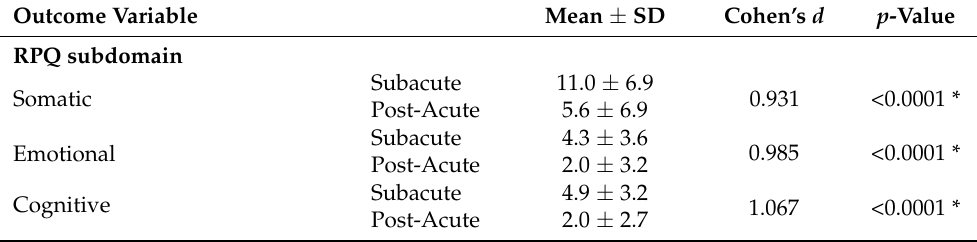
Table 3. Descriptive outcome values for concussed participants at the subacute and post-acute